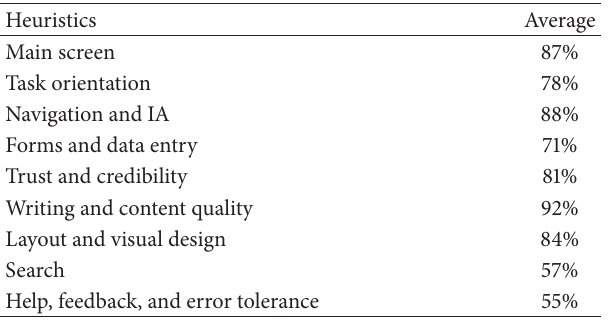
Table 5: Overall score for each evaluated